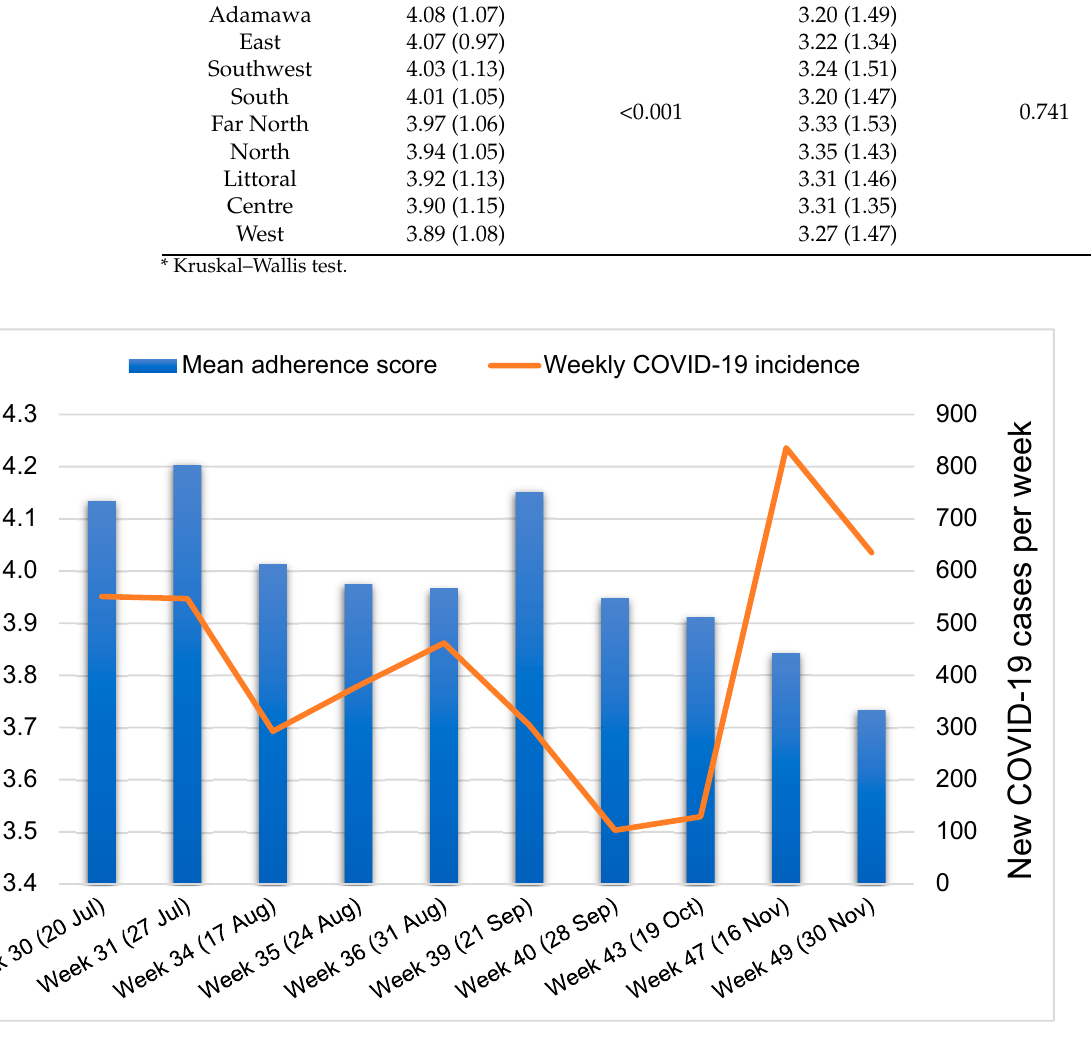
Figure 1. Evolution of COVID-19 burden and adherence scores in Cameroon.